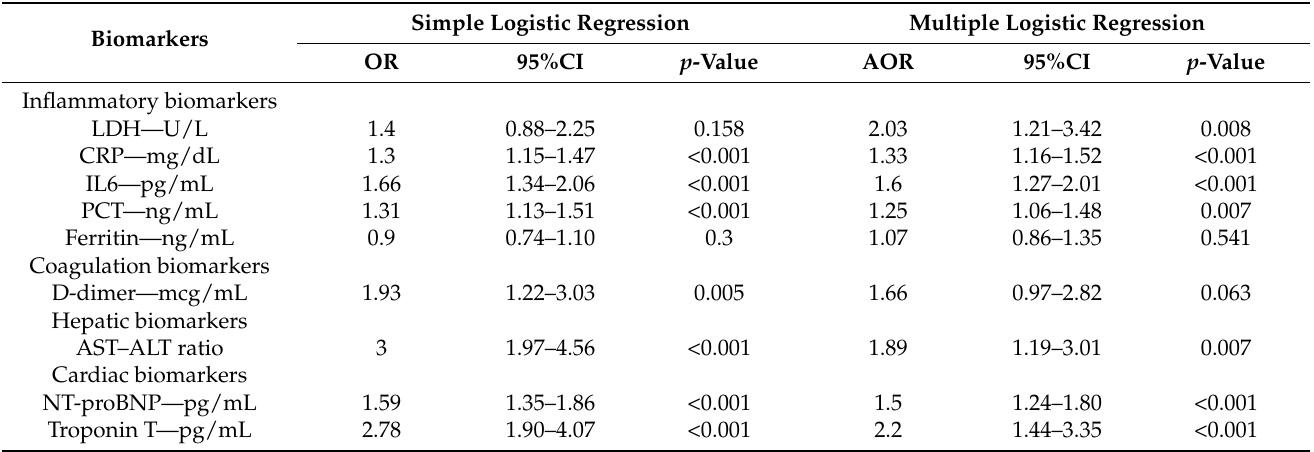
Table 2. Logistic regression analysis of biomarkers with in-hospital mortality.